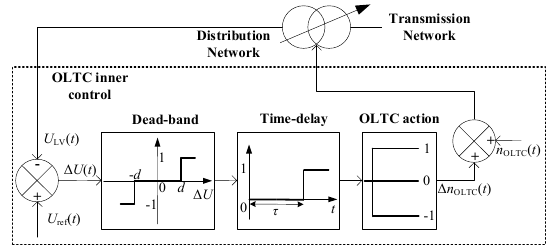
Figure 1. The inner control of